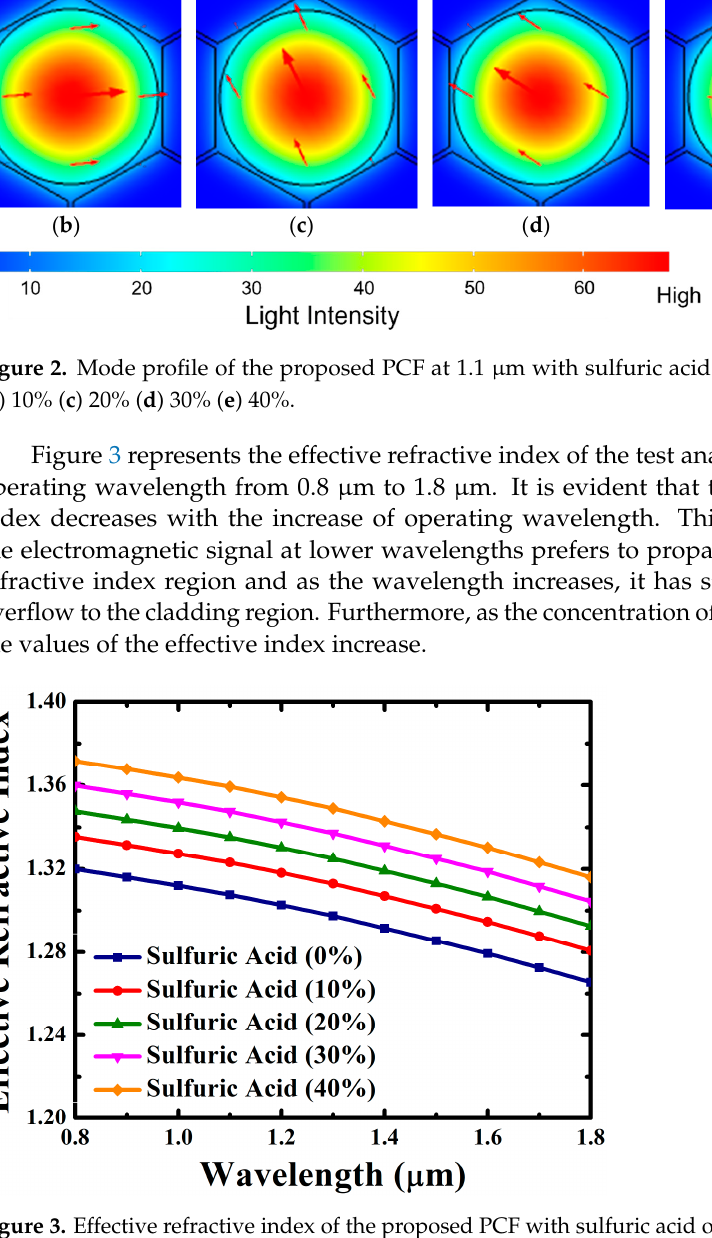
Figure 3. Effective refractive index of the proposed PCF with sulfuric acid of different concentrations: 0%, 10%, 20%, 30%, and 40%. 0%, 10%, 20%, 30%, and